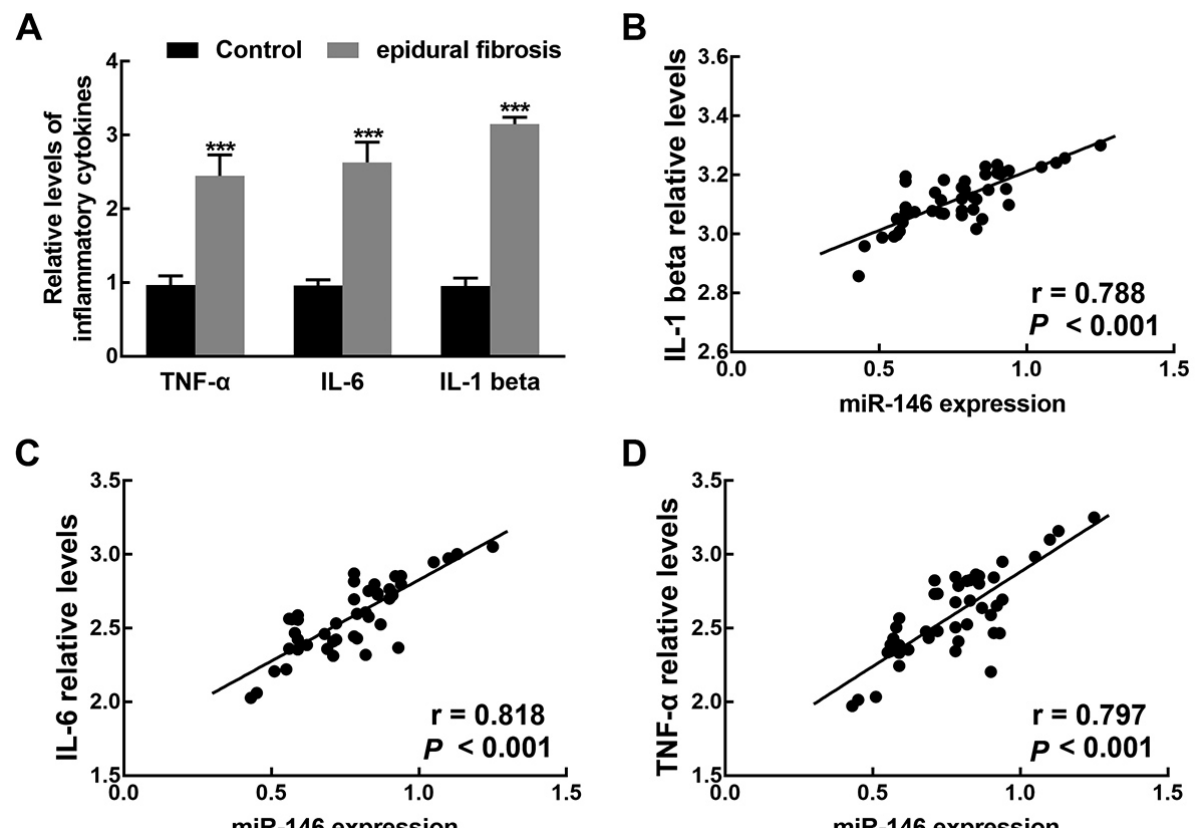
Figure 3 – The relative levels of TNF-α, IL-6, and IL-1 beta and their correlation with the expression of miR-146. A. The relative levels of TNF-α, IL-6, and IL-1 beta were significantly higher in epidural fibrosis patients than that of control patients. *** P < 0.001.B. The expression of miR-146 was positively correlated with the relative levels of IL-1 beta with the r value of 0.788. C. The expression of miR-146 was positively correlated with the relative levels of IL-6 with the r value of 0.818. D. The expression of miR-146 was positively correlated with the relative levels of TNF-α with the r value of 0.797. All P < 0.001.